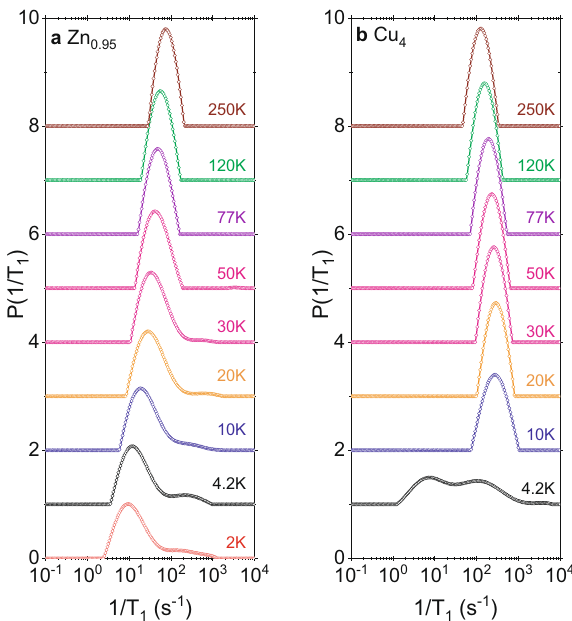
Fig. 5 Density distribution function P (1/ T 1 ). a Representative results of P (1/ T 1 ) deduced at the peak frequency 19 f peak of the 19 F NMR linehapes observed for Zn 0.95 . The integral of P (1/ T 1 ) is normalized to 1 (one). b Corresponding results observed for Cu 4 . Notice that the side peak of P (1/ T 1 ) observed for Zn 0.95 with 1/ T 1 ~300 s − 1 is absent for Cu 4 . The large distribution observed at 4.2 K is caused by antiferromagnetic long-range order. We fi xed the Tikhonov regularization parameter for ILT as α = 1 to achieve the same effective resolution. The distributions of 1/ T 1 is negligibly small with β ≃ 1 above ~160 K for Zn 0.95 and above T N = 15 K for Cu 4 , hence the apparent width of P (1/ T 1 ) in these regions is set primarily by the effective resolution of our ILT with fi xed α = 1. (See Supplementary Materials of refs. 21,38 for details about the effective resolution of the ILT